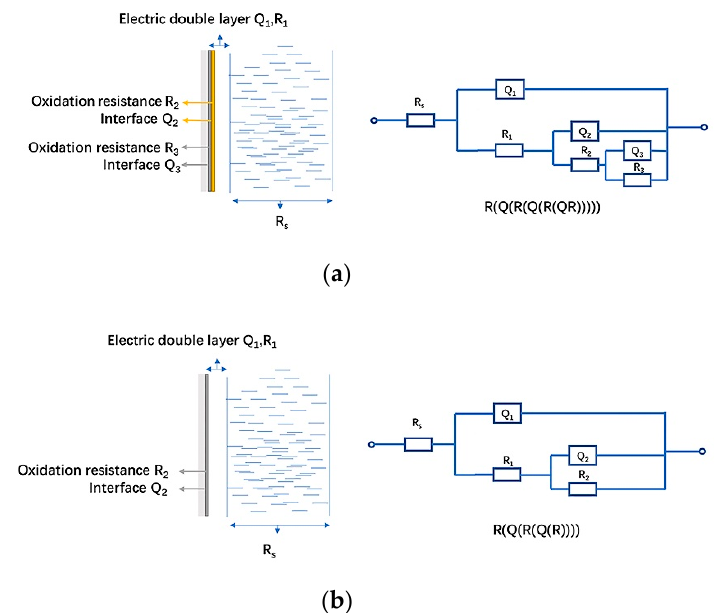
Figure 6. The theoretical model and analog circuit from electrochemical impedance spectroscopy (EIS) in the three investigated solutions: ( a ) analog circuit from EIS of the galvanic pair and arsenopyrite in sulfuric acid solution; and ( b ) the galvanic pair and arsenopyrite in ferric ion and HQ0211 strain solutions. Table 3. Fitting data and fitting errors of the investigated electrochemical impedance spectroscopy (EIS) data.